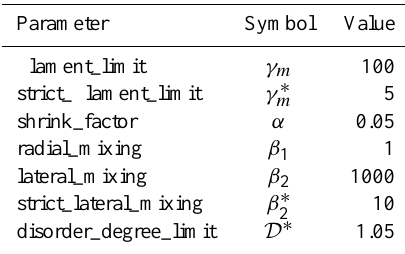
Table 1. Key parameters of